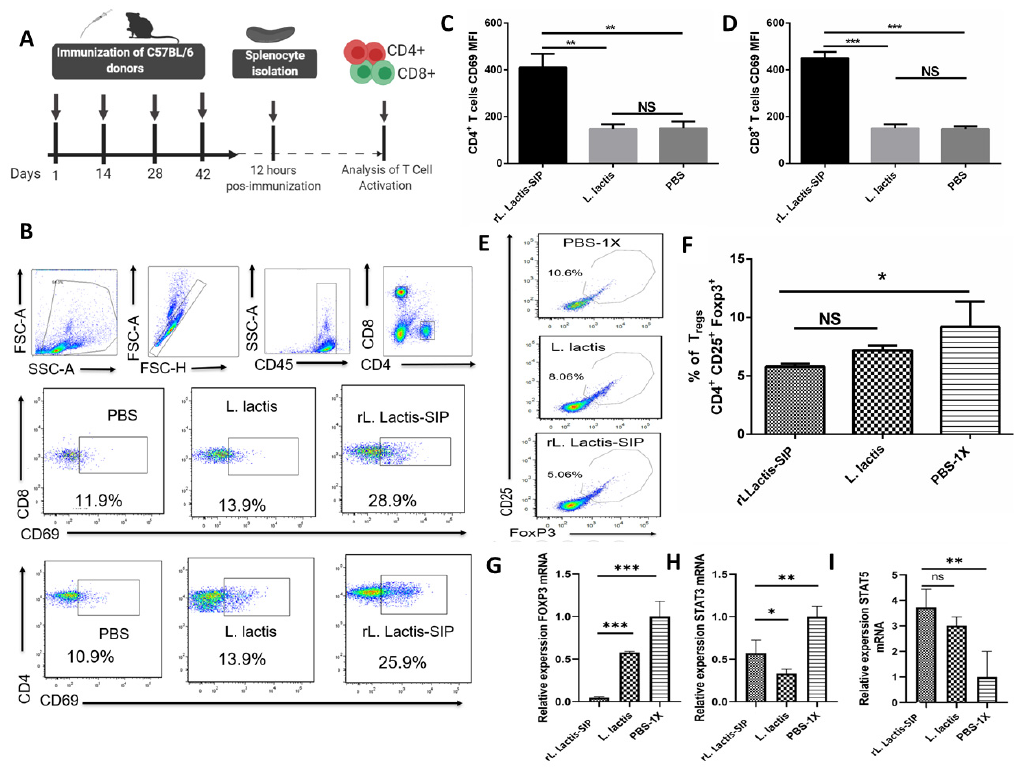
Figure 4. Oral immunization with rL. lactis -SIP induced the activation of T cells. ( A ) Representation of the immunization used in the C57BL/6 mice experiment. The mice (four per group) were orally immunized four times with 1 × 10 10 rL. lactis -SIP at intervals of 14 days. ( B ) CD69 expression on the surface of T cells after stimulation with rSIP. At 24 h after the last immunization with either rL. lactis -SIP, L. lactis , or PBS, spleen cells were collected to evaluate the specific T cell response. Graphs show mean fluorescent index (MFI) of CD69 expression by ( C ) CD4 + and ( D ) CD8 + T cells derived from rL. lactis -SIP, L. lactis , and PBS-immunized mice. Spleen cells were stained with anti-CD8, anti-CD4, and anti-CD69 antibodies (Abs) and analyzed by flow cytometry. ( E ) Representative flow cytometry plots gated on live CD4 T cells quantify the percentage of CD4 + CD25 + Foxp3 + (forkhead box P3) Tregs obtained from splenocytes. Flow cytometry detection of ( F ) CD4 + CD25 + FoxP3 expression by T cells derived from rL. lactis -SIP, L. lactis -, and PBS-immunized mice. Spleen cells were stained with anti-CD4, anti-CD25, and anti-Foxp3 Abs and analyzed by flow cytometry. A total of 30,000 events was acquired in all the experiments using a FACSverse cytometer and analyzed with the FlowJo software. Results represent one of two independent experiments with similar results. Data are shown as mean ± SD of four mice in each group. Asterisks indicate a significant di ff erence versus PBS-immunized mice (not significant (ns); * p < 0.05; ** p < 0.01; *** p < 0.001). Activation of splenocytes obtained from oral-immunization mice was determined by gene profiles of ( G ) Foxp3, ( H ) Signal transducer and activator of transcription (STAT)-3, and ( I ) STAT-5 from total RNA splenocytes. Splenocytes were stimulated ex vivo for 4 days with purified rSIP. Data are expressed as the increase compared to PBS-immunized mice in the expression of the number of Foxp3, STAT-3, and STAT-5 gene copies per β -actin gene copies. Data are shown as mean ± SD of four mice in each group. One of two independent experiments with similar results is shown. Asterisks indicate a di ff erence between groups (not significant (ns); * p < 0.05; ** p < 0.01; *** p <